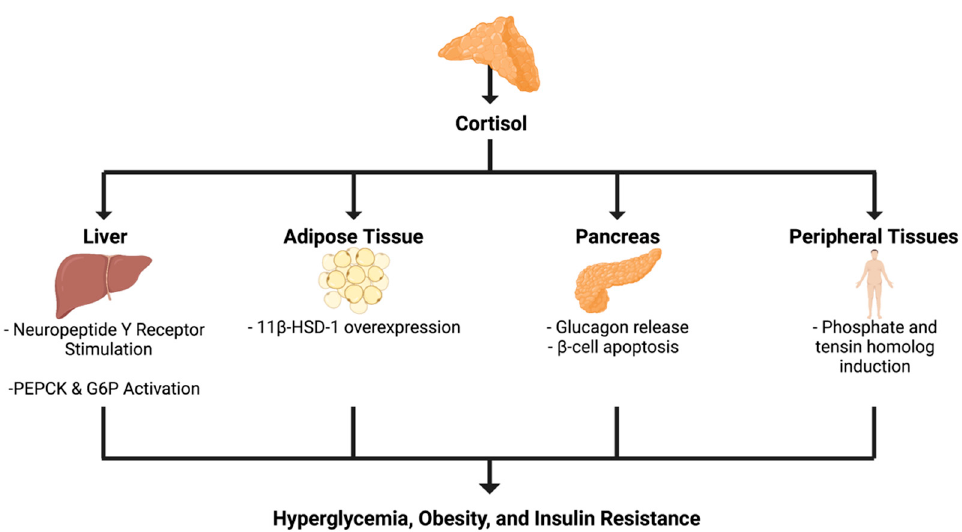
Figure 4. Direct effects of cortisol on body tissues lead to insulin resistance. Figure created using biorender.com (accessed on).